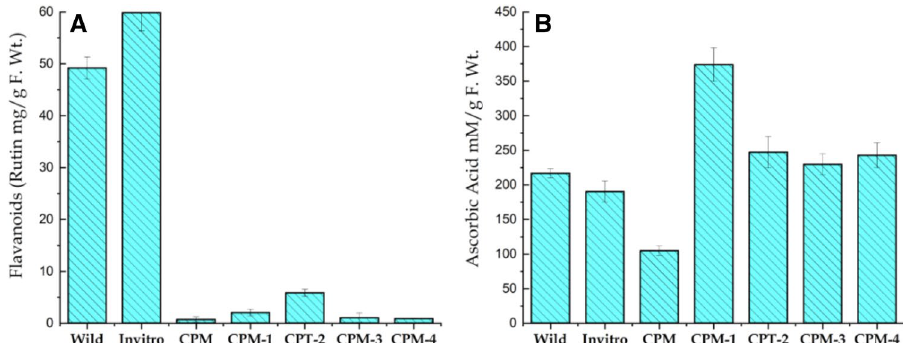
Figure 4. Variation in the Total Flavenoids ( A ) and Ascorbic acid ( B ) contents of S. costus collected from wild, micro propagated plant and induced callus grown on simple callus promoting media (CPM) supplemented with Kinetin (0.5 mgL -1 ) and 2.4-D (1.0 mgL -1 ) and callus subjected to various stresses i.e. 60 gL -1 D-Sorbitol stress